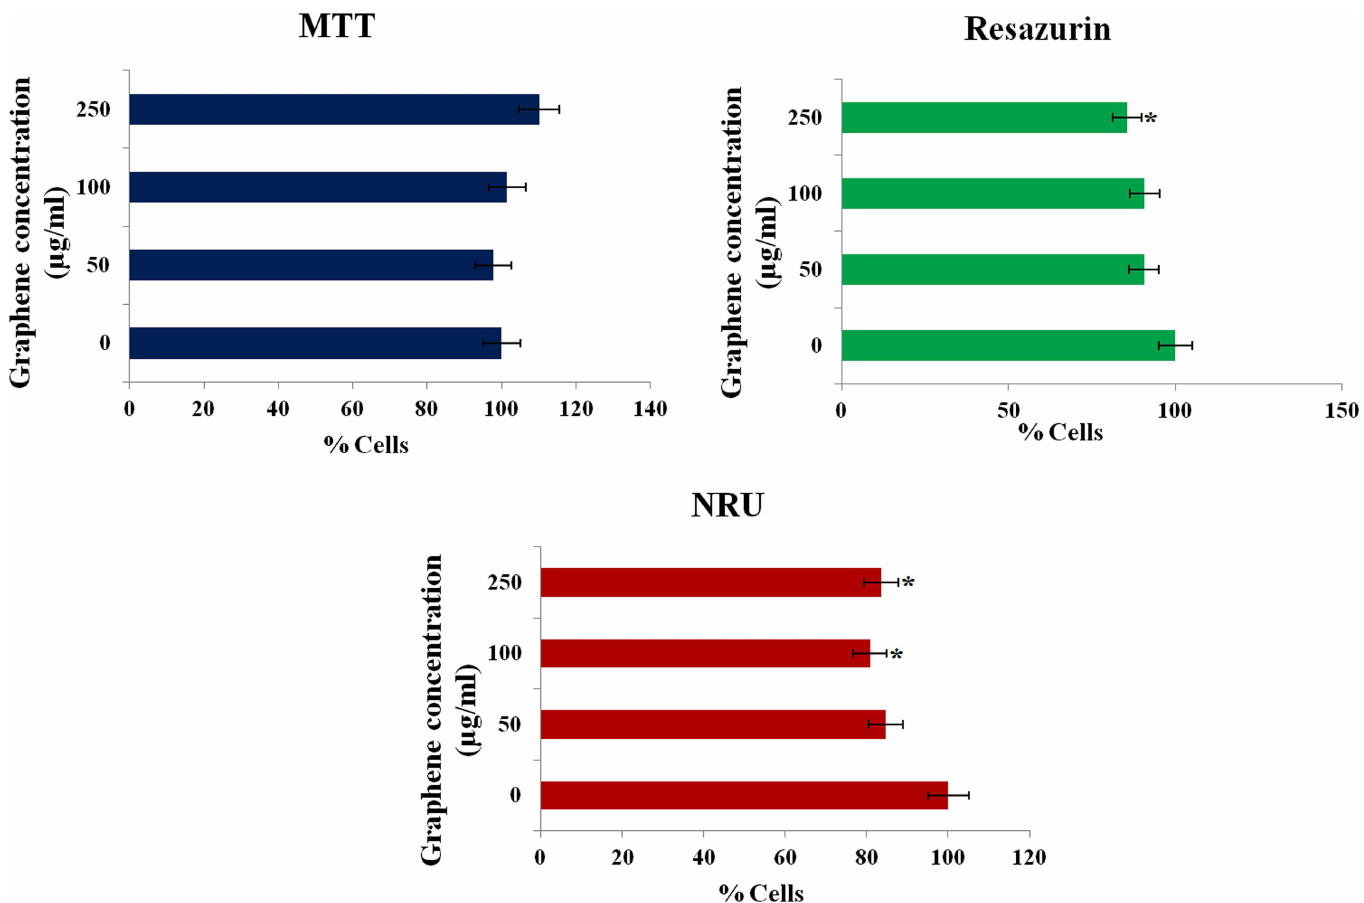
Fig 9. Cytotoxicity of PR-GO in terms of MTT, Resazurin and neutral red uptakeassays.